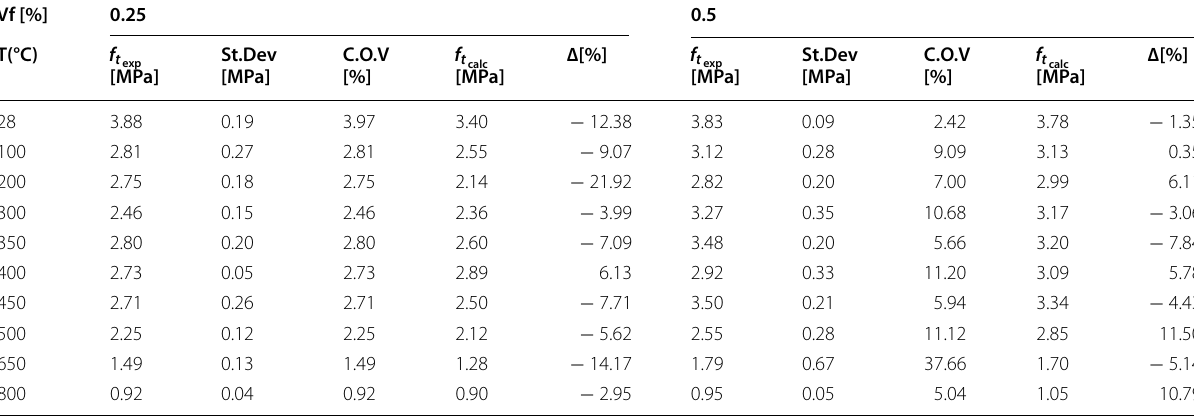
Table 7 Comparison between the experimental and predicted tensile